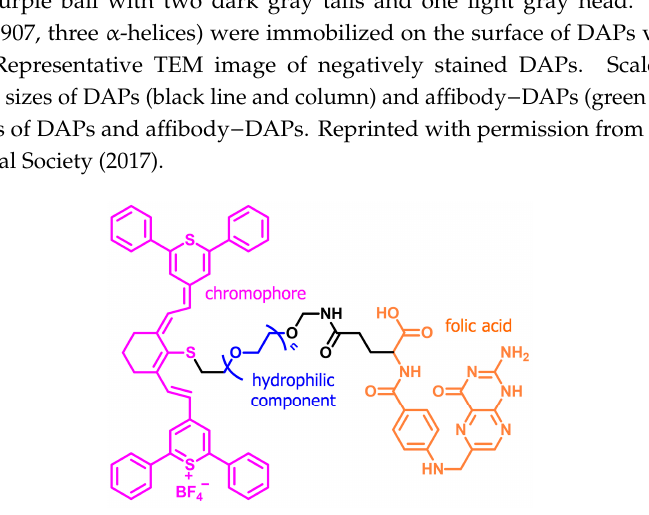
Figure 19. Chemical structure of a multifunctional small molecule that enables target-specific, high-resolution imaging.